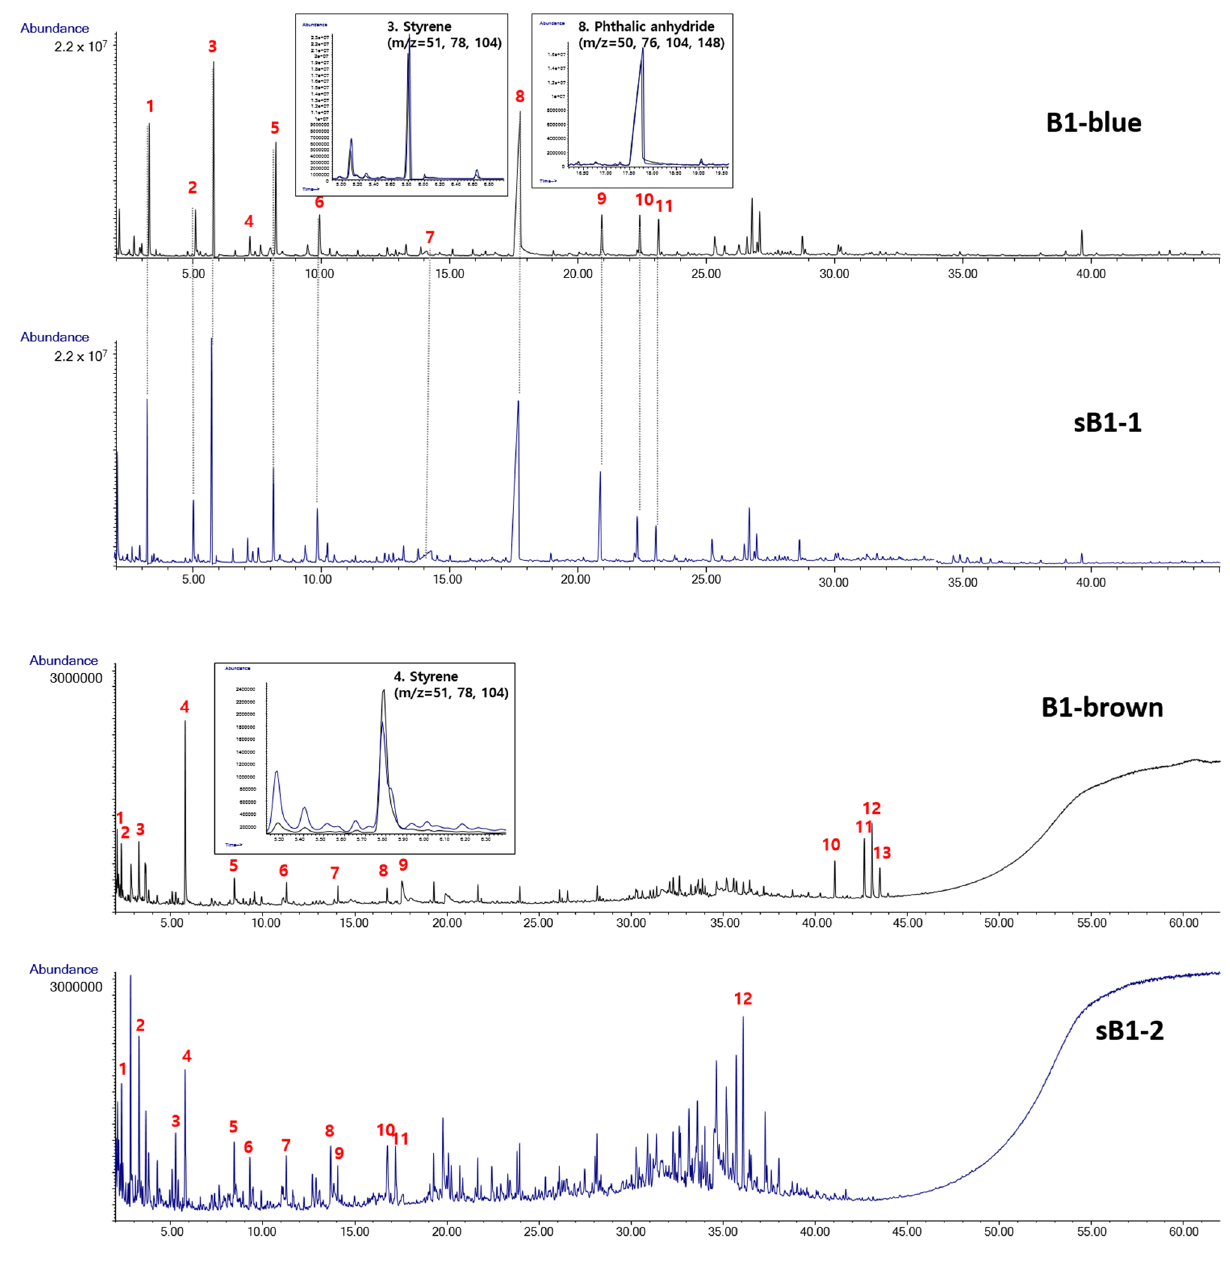
Figure 5. Py–GC/MS spectra of Case II